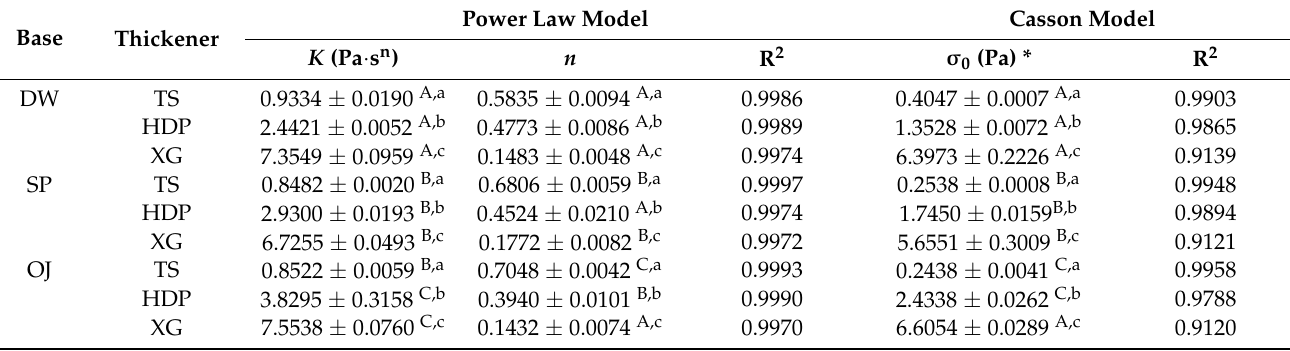
Table 4. Regression models of power law and Casson models for thickened fluid matrices formulated with different thickeners and aquatic continuous phases (bases)